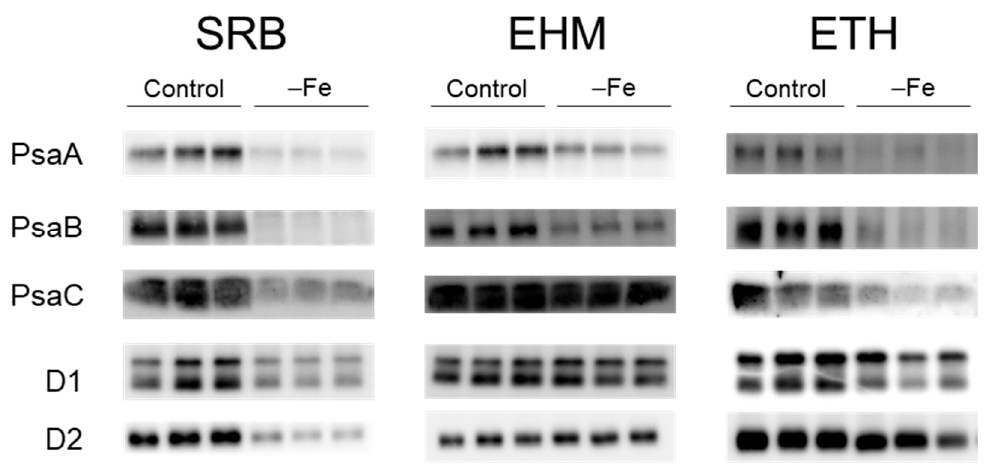
Figure 5. The decrease in the accumulation of reaction-center proteins under the Fe-deficient condi- tion. PsaA, PsaB, and PsaC of PSI reaction-center and D1 and D2 of PSII reaction-center were detected using each specific antibody. Each lane was loaded with 50 μ g of chlorophyll. A set of three lanes means three independent plants. Images of CBB staining are shown in Figure S3.